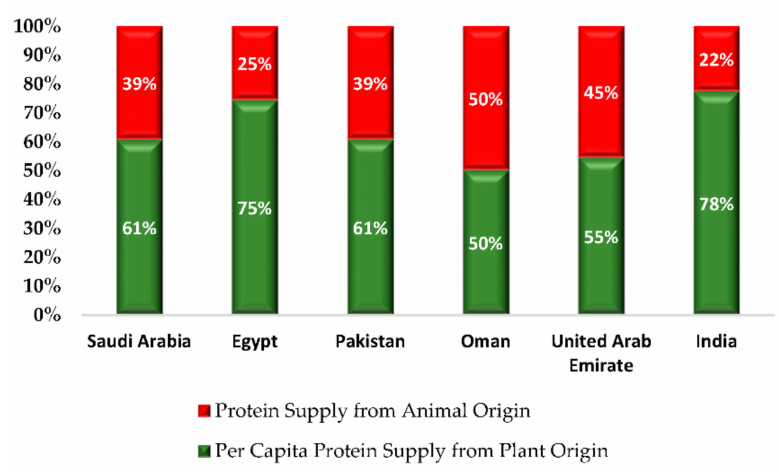
Figure 3. Share of plant versus animal protein source on average per capita diet.